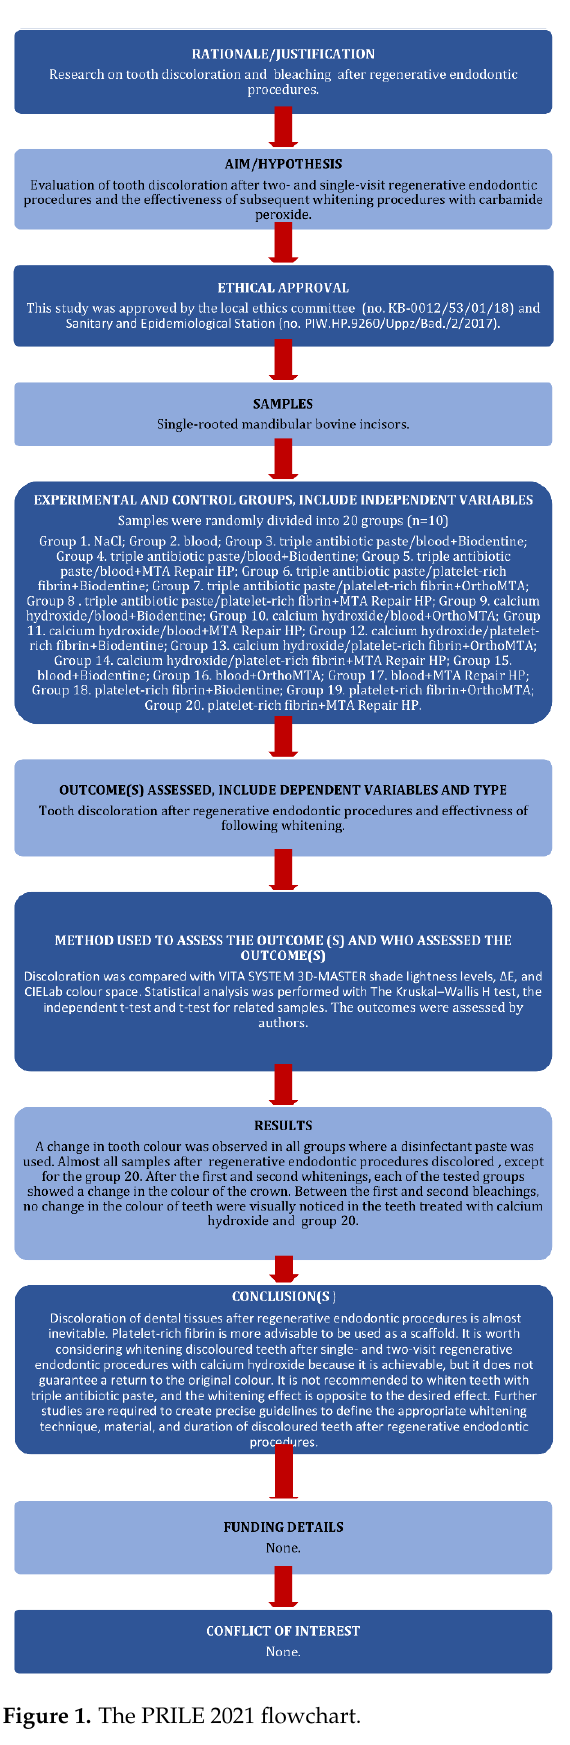
Figure 1. The PRILE 2021 flowchart.